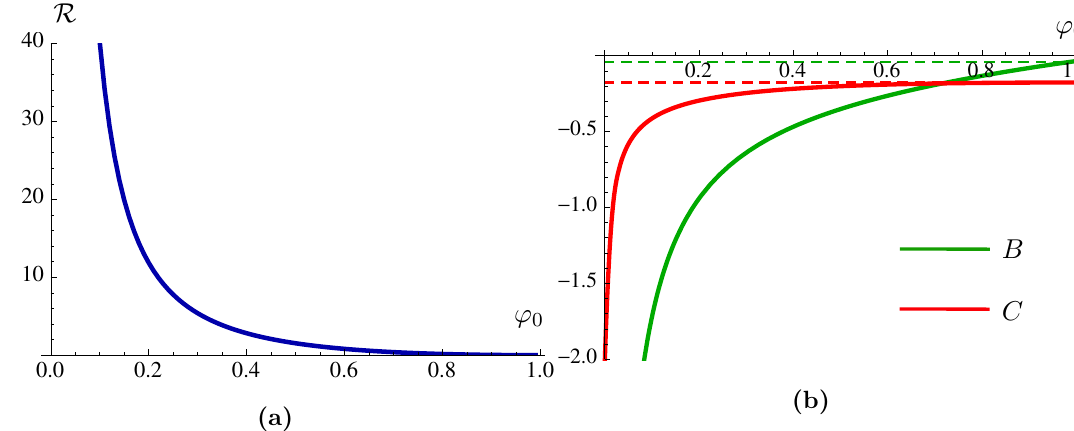
Figure 4. (a): dimensionless curvature R vs. IR end point ’ 0 for the potential (2.45) with d = 3, (cid:1) (cid:0) = 1 : 2 and (cid:21) chosen such that ’ min = 1. Note that R increase as the IR end point ’ 0 moves closer to the UV (cid:12)xed point at ’ = 0. When ’ 0 ! ’ min = 1 the solutions asymptote to RG (cid:13)ows for a theory on (cid:13)at space-time and hence R ! 0. (b): B and C vs. ’ 0 for the same model parameters as in (a). Note that for ’ 0 ! ’ min = 1 both B and C attain a (cid:12)nite value indicated by the dashed green and red line, respectively. Here one (cid:12)nds that B and C decrease monotonically as ’ 0 is decreased, ultimately diverging for ’ 0 ! ’ max =